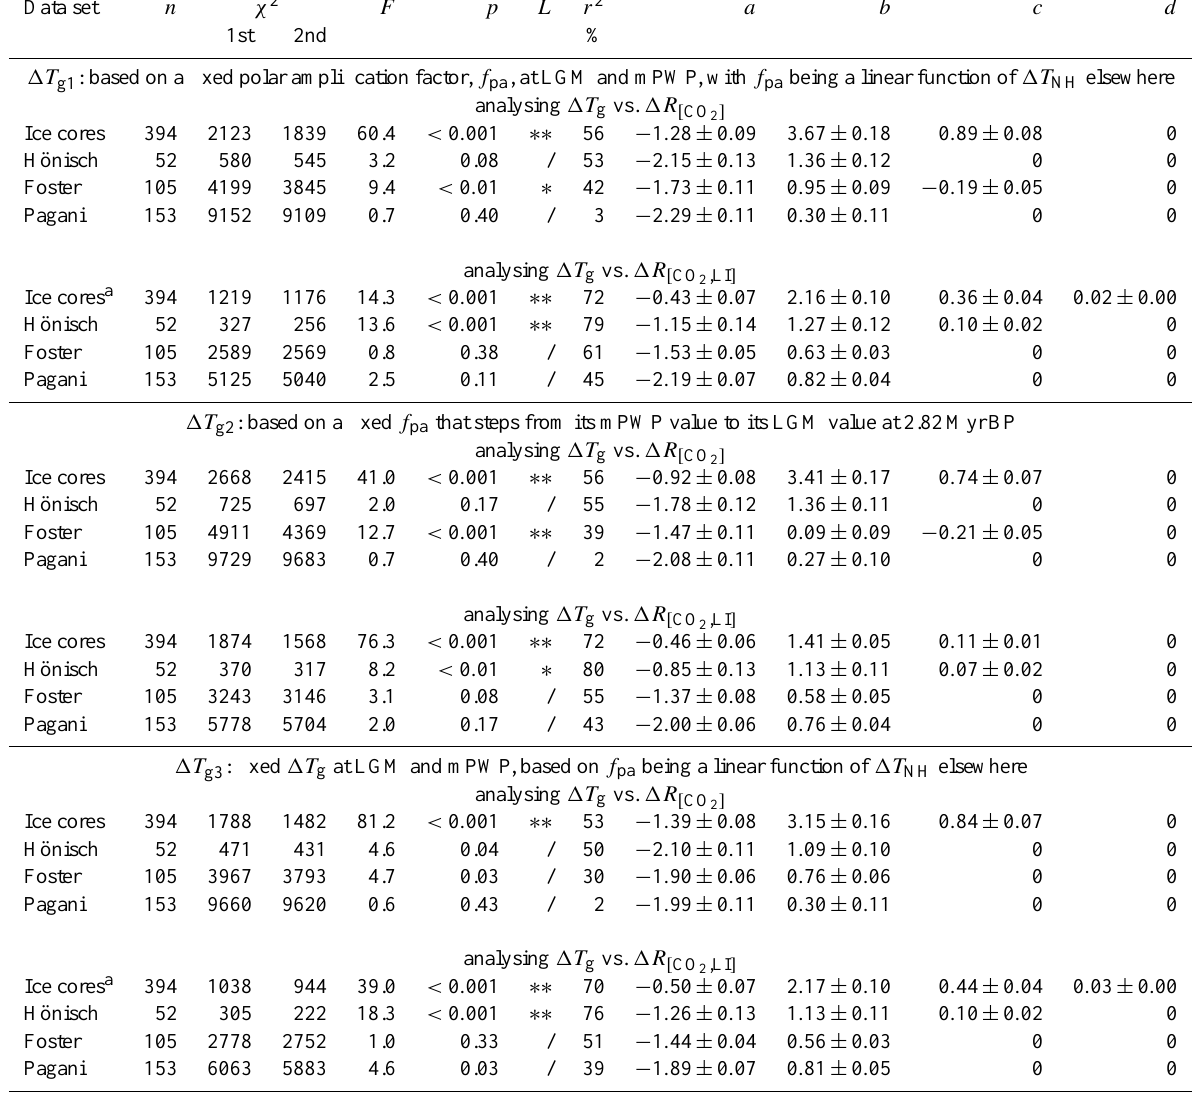
Table 1. Fitting a linear or a non-linear function to the data: 5000 Monte Carlo-generated realizations of the scattered (cid:49)T g – (cid:49)R [ CO (cid:49)T g – (cid:49)R [ CO were analysed. The data are randomly picked from the entire Gaussian distribution described by the 1 σ of the given 2 ,LI ] uncertainties in both (cid:49)T g and (cid:49)R [ X ] . The parameter values of fitted polynomials are given as mean ± 1 σ uncertainty from the different Monte Carlo realizations. Data sets differ in the underlying (cid:49)T g and CO 2 data. (cid:49)T g : either (cid:49)T g or polar amplification, f pa , are fixed at LGM and mPWP at values from PMIP3 and PlioMIP with different functionality for f pa (see methods for details). CO 2 data from ice cores and Hönisch, Foster, and Pagani